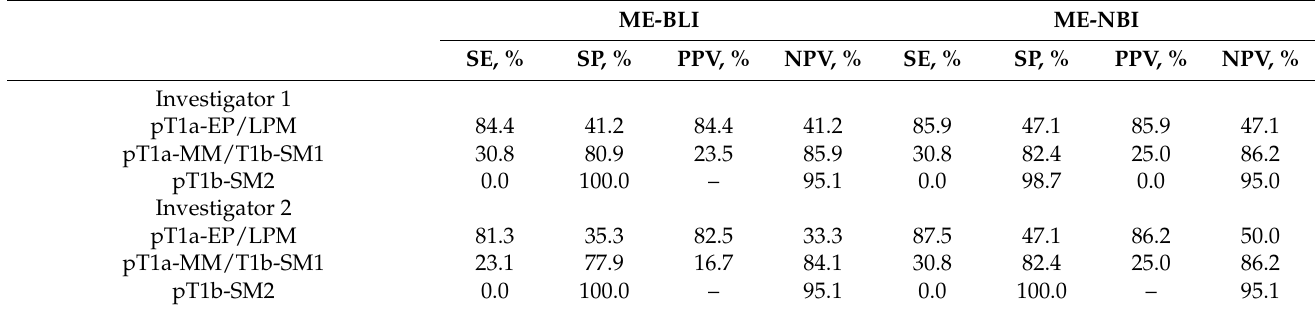
Table 3. Diagnostic ability for the invasion depth of SESCC by the JES’s IPCL classification between ME-BLI and ME-NBI. ME-BLI ME-NBI SE, % SP, % PPV, % NPV, % SE, % SP, % PPV, % NPV, %